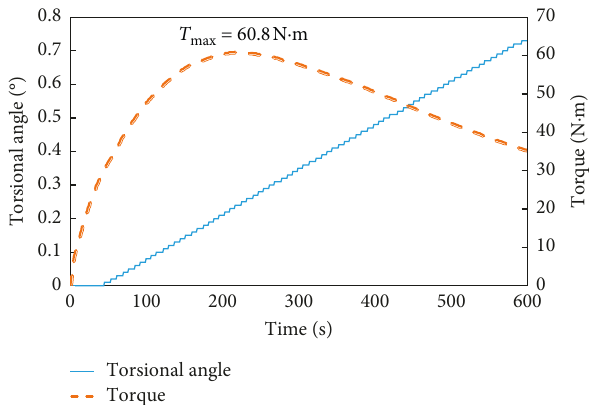
Figure 10: Torque and torsional angle versus time (AC-13).